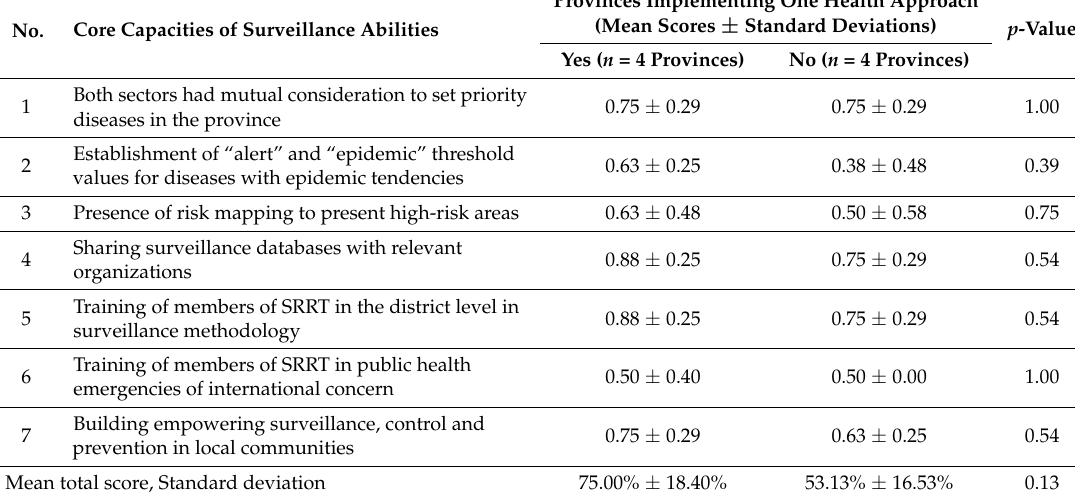
Table 2. Assessment of surveillance capacities between the provinces that implemented the One Health approach and provinces that did not implement the One Health approach in Thailand,